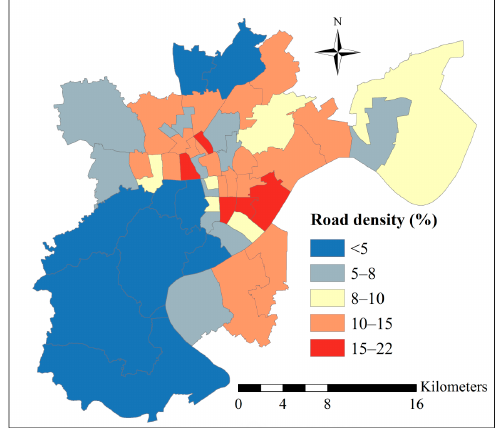
Figure 6. Road density for the street-town unit.